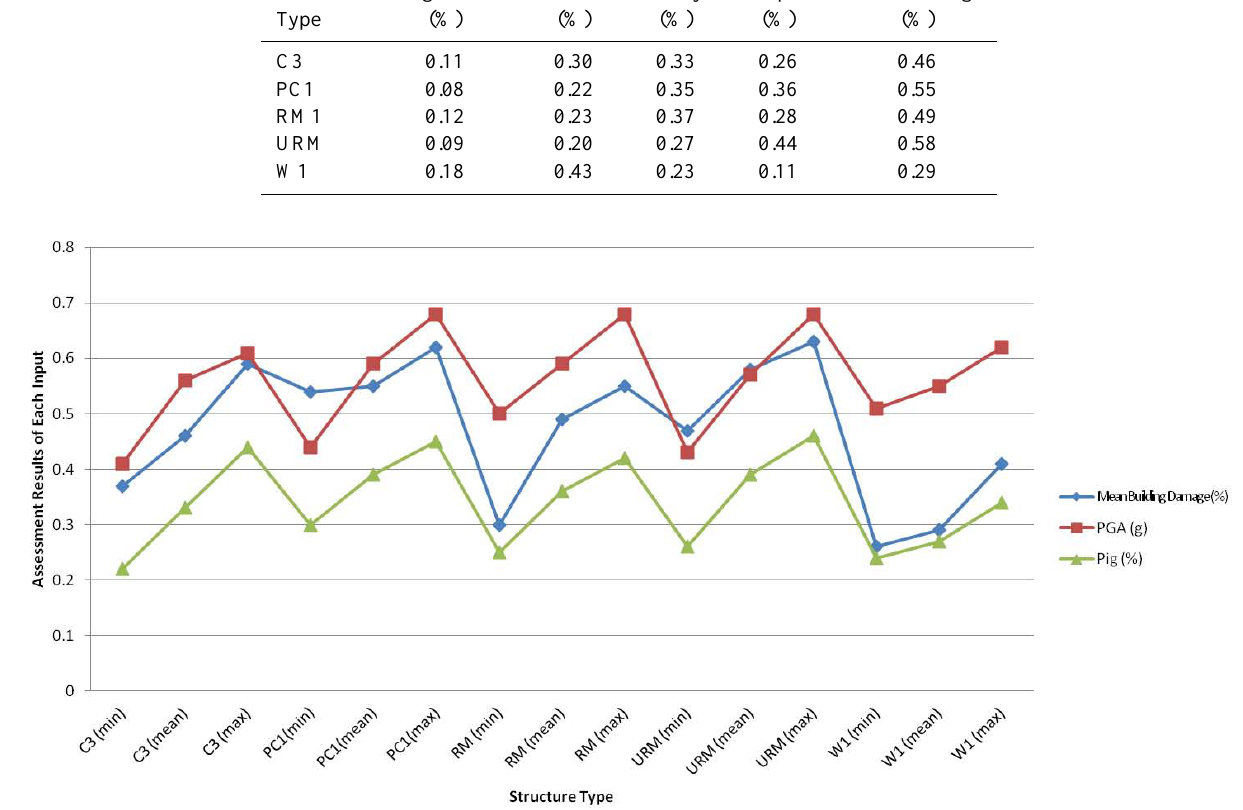
Fig. 10. Distribution of mean building damage, PGA, and ignition probability.